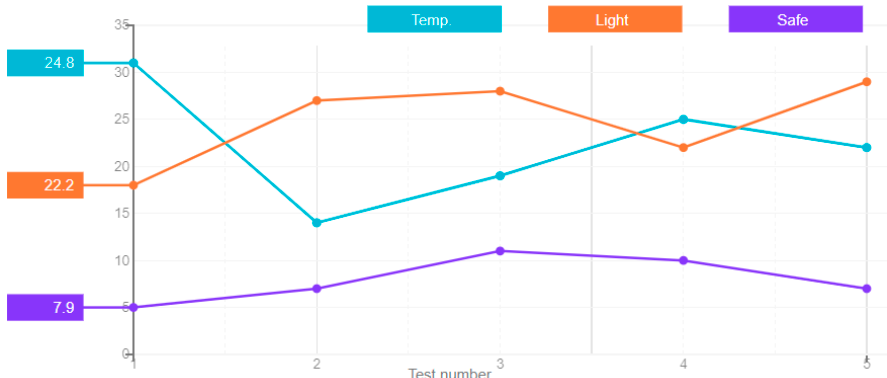
Figure 6. A graph of the long short-term memory ANN’s error value.